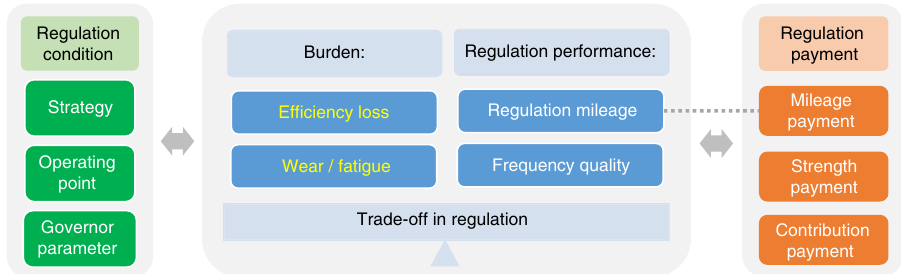
Fig. 1 Framework for quantifying and evaluating the regulation of hydropower units. Ef fi ciency loss as well as wear and fatigue are adopted to represent the burden; regulation mileage and frequency quality are applied to evaluate the regulation performance